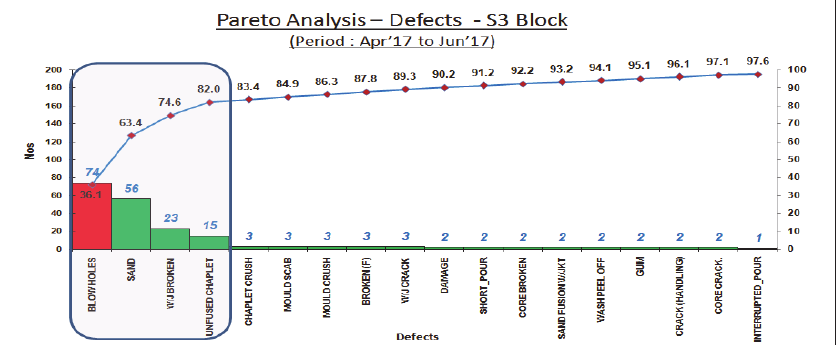
Fig. 3. Understanding the Problem – Pareto Analysis of S3 Block